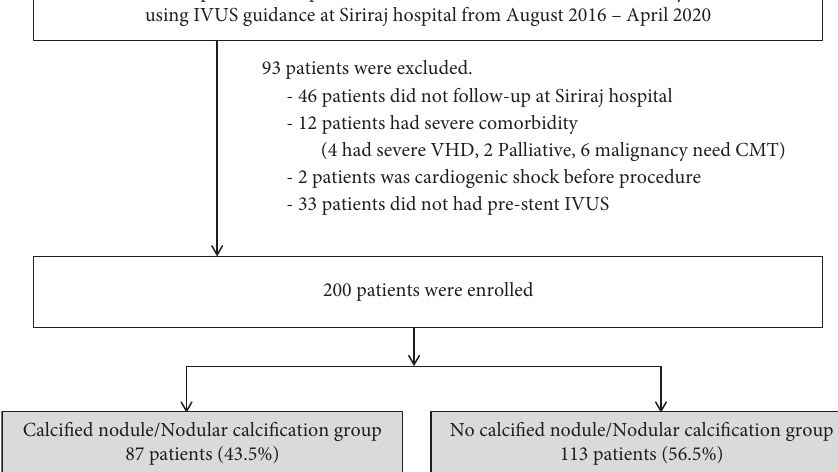
Figure 1: Flow diagram describing the patient enrollment protocol. PCI: percutaneous coronary intervention and IVUS: intravascular